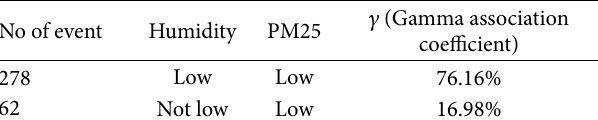
Table 6: Gamma association coefficient between the daily average of humidity and PM2.5.